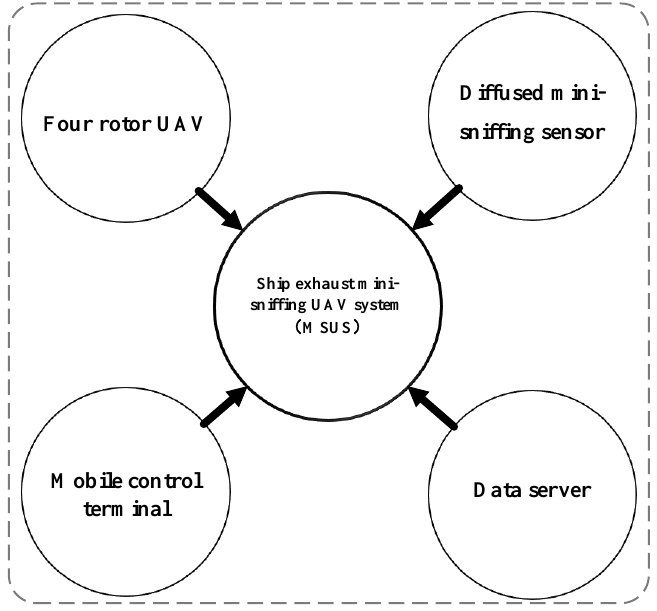
Figure 1. The structure of ship exhaust mini-sniffing UAV system. The DJI Phantom 4 Pro V2.0 UAV (SZ DJI Technology Co., Ltd., Shenzhen,